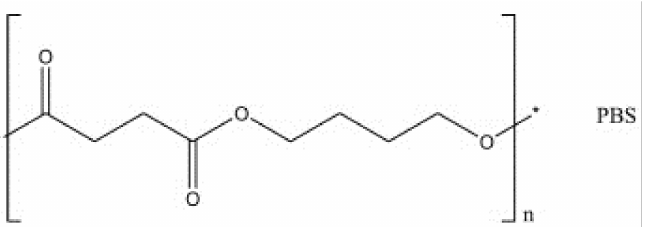
Figure 3. Chemical structure of polybutylene succinate (PBS) [43]. Copyright obtained from